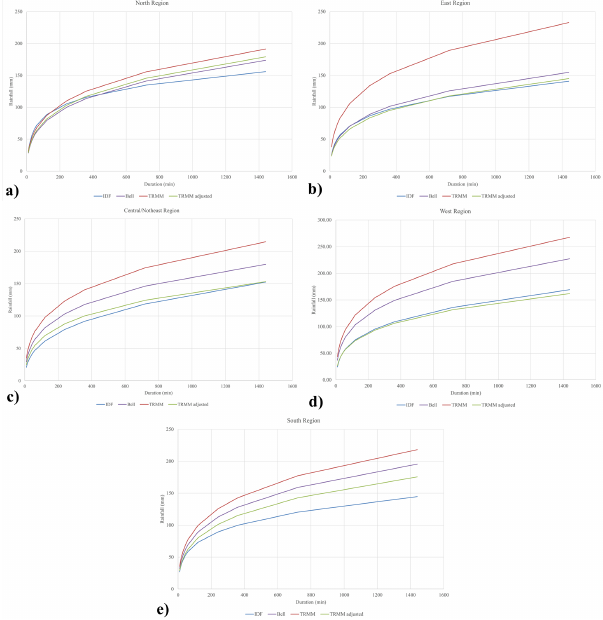
Figure 3. Errors between TRMM adjusted and IDF at each